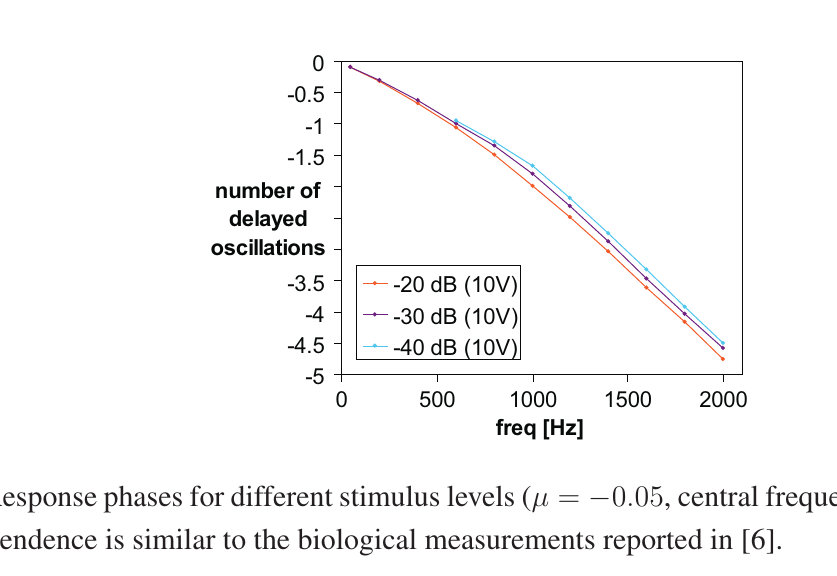
Figure 6 . Instantaneous frequency response to click stimulation at different stimulus levels ( µ = − 0 . 05 , central frequency: 1480 Hz, section 5). The response is close to the biological measurements reported in [28].